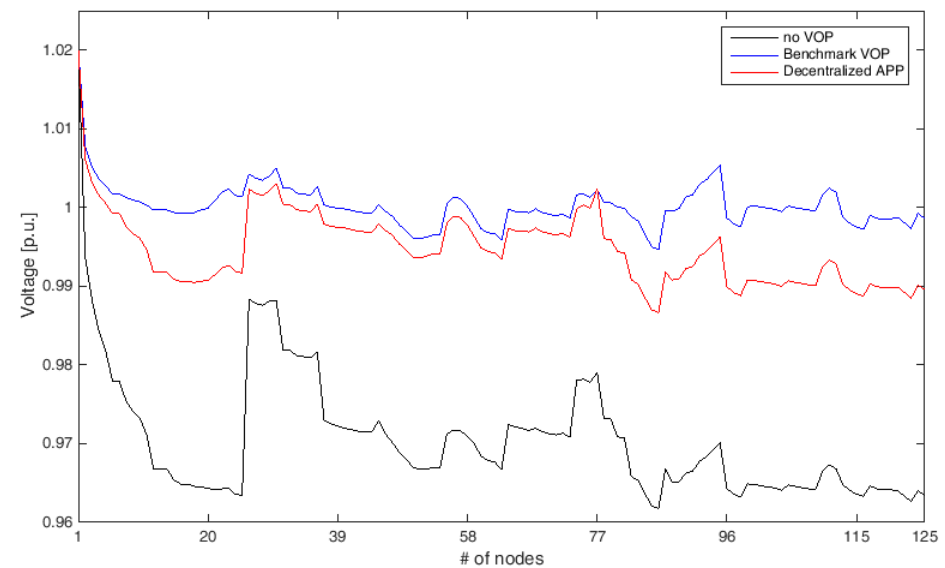
Figure 17. The network voltage profile for the no VOP , Benchmark VOP, and Decentralized APP in Case 3